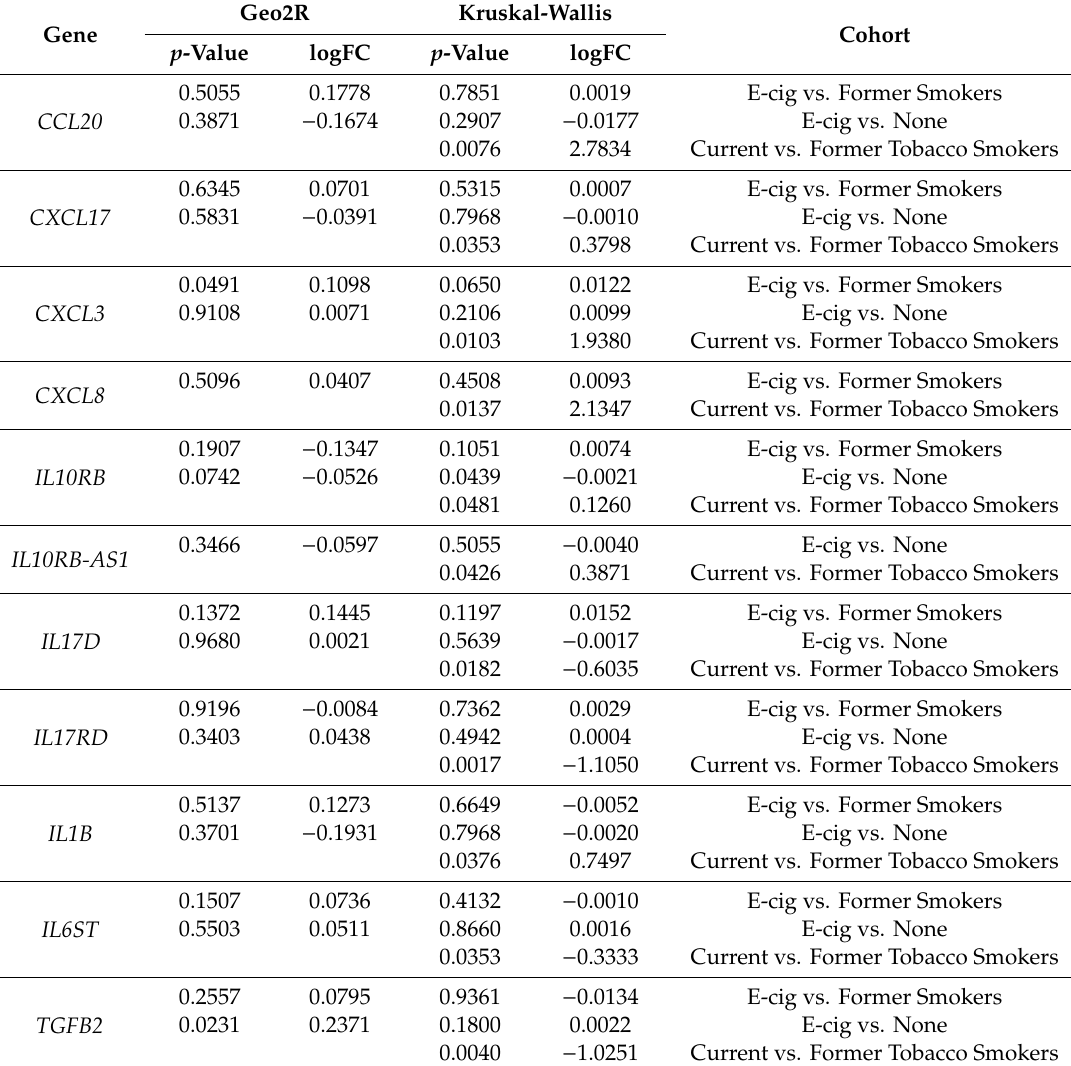
Table 1. Significantly dysregulated cytokine-related